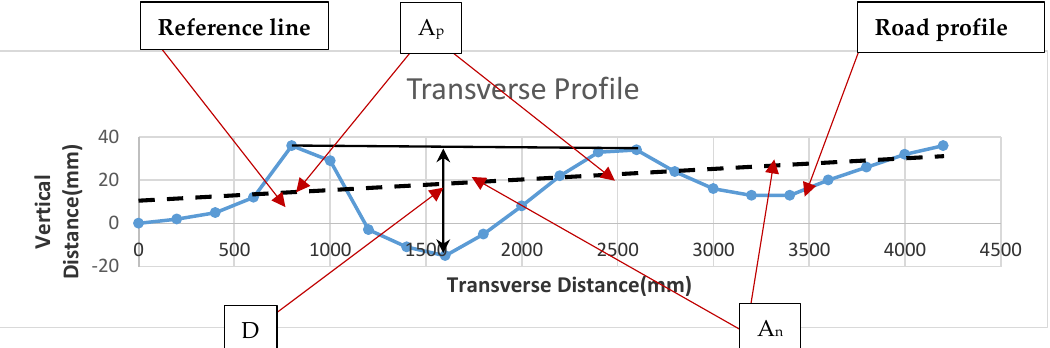
Figure 2. Plot of transverse profile from the edge of a shoulder to the center line of a lane. A p = area above dotted line; A n = area below dotted line; D = maximum rut depth.